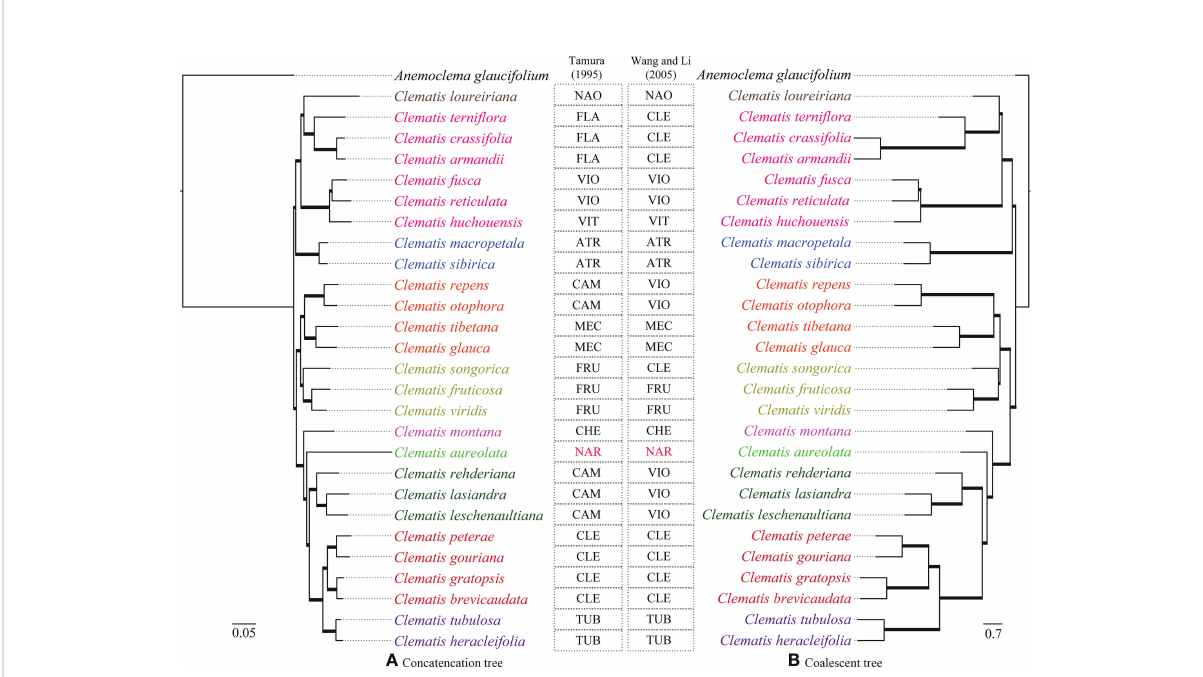
FIGURE 3 Phylogenetic trees inferred from SCOG1000 dataset by the concatenated (left) and the coalescence-based (right) methods. All clades of both trees are 100% supported and all the branches are in bold. Section abbreviations are: sect. Atragene (ATR), sect. Naraveliopsis (NAO), sect. Clematis (CLE), sect. Flammula (FLA), sect. Viorna (VIO), sect. Viticella (VIT), sect. Campanella (CAM), sect. Meclatis (MEC), sect. Fruticella (FRU), sect. Cheiropsis (CHE), sect. Tubulosae (TUB), Naravelia